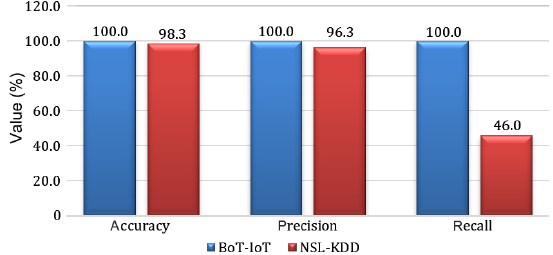
Fig. 7 Performance metrics of our model with NSL-KDD and BoT-IoT datasets.